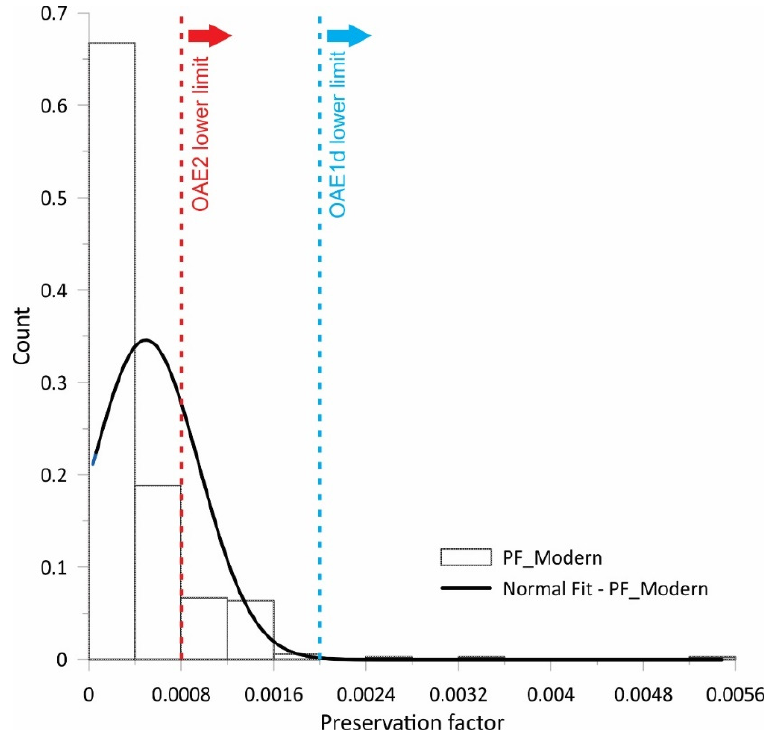
Figure 5. Histogram of modern preservation factor (PF) values and lower limits of the PF distributions for the OAEs.